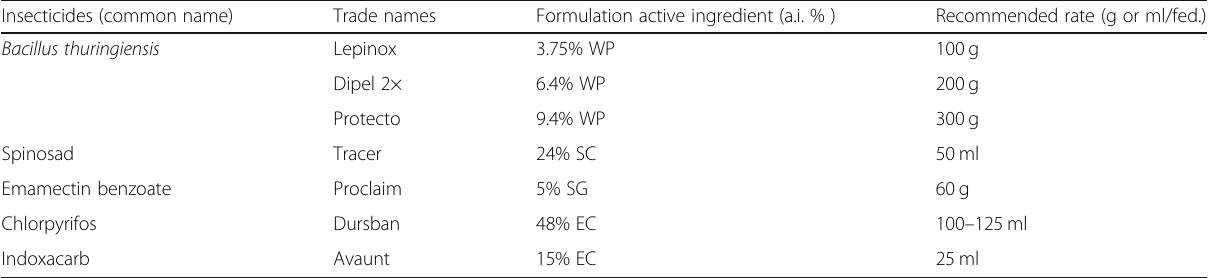
Table 1 Tested bio-and chemical insecticides and their rates of application Insecticides (common name) Trade names Formulation active ingredient (a.i. %